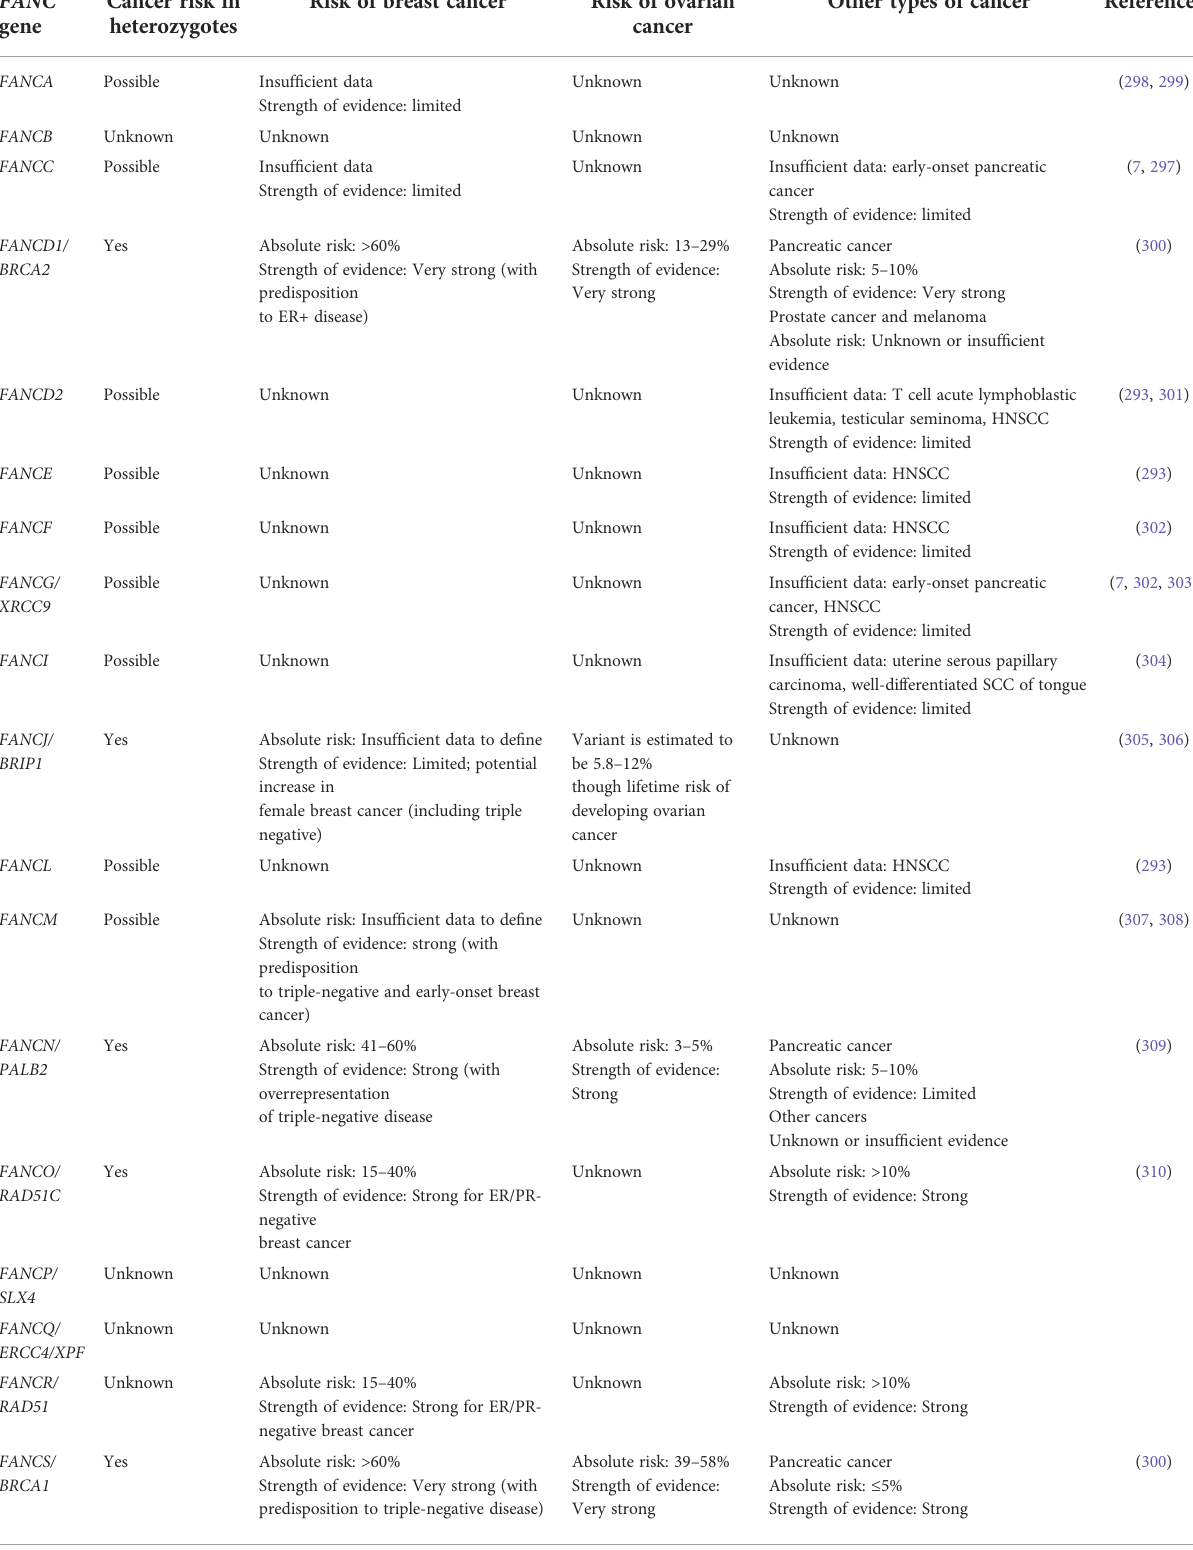
TABLE 3 Heterozygous Pathogenic Variants in FANC Genes and Cancer